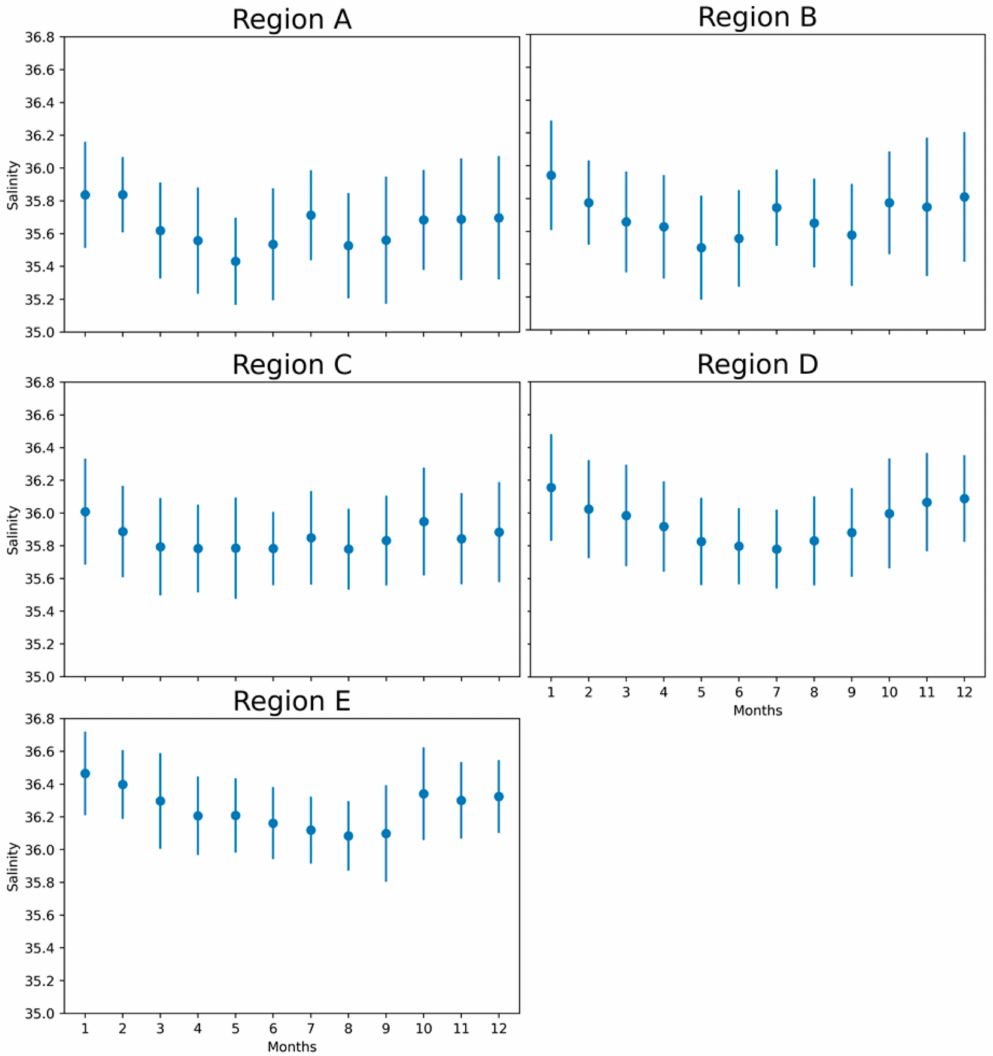
Figure 13. Monthly averages of the spatially averaged sea surface salinity obtained for regions A, B, C, D, and E, using the data from 2011 to